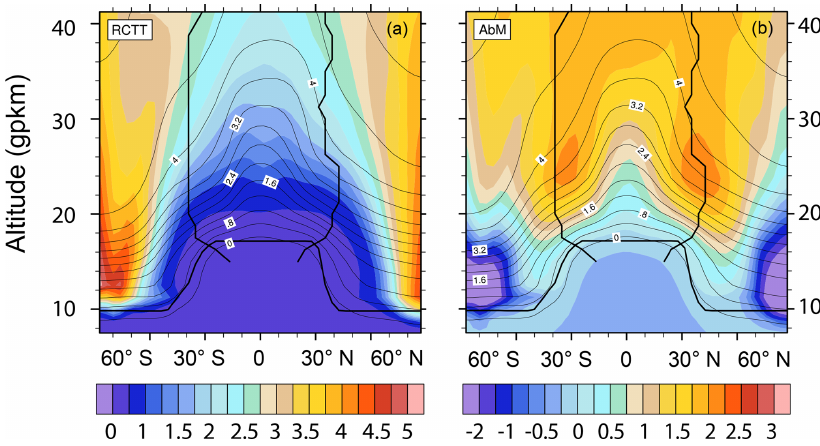
Figure 8. (a) CMAM zonal mean RCTTs (year) and (b) AbM averaged over the 1970–2000 period. The thick black lines show the mean tropopause and the turnaround latitude positions in the Ref